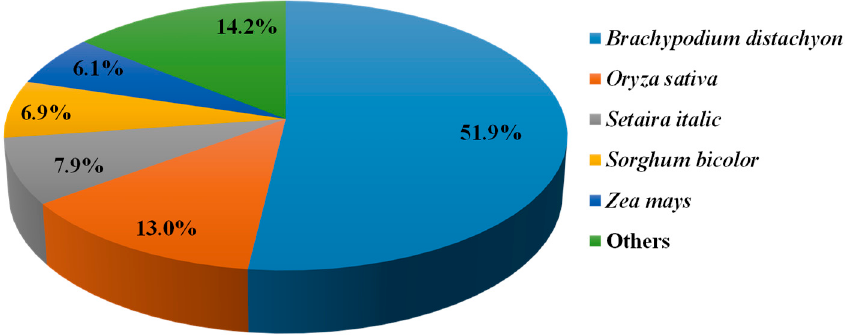
Figure 3. Taxonomic source and distribution (%) of the top results from a BLAST algorithm-based search using creeping bentgrass sequences. Table 2. Annotation summary of creeping bentgrass unigenes.